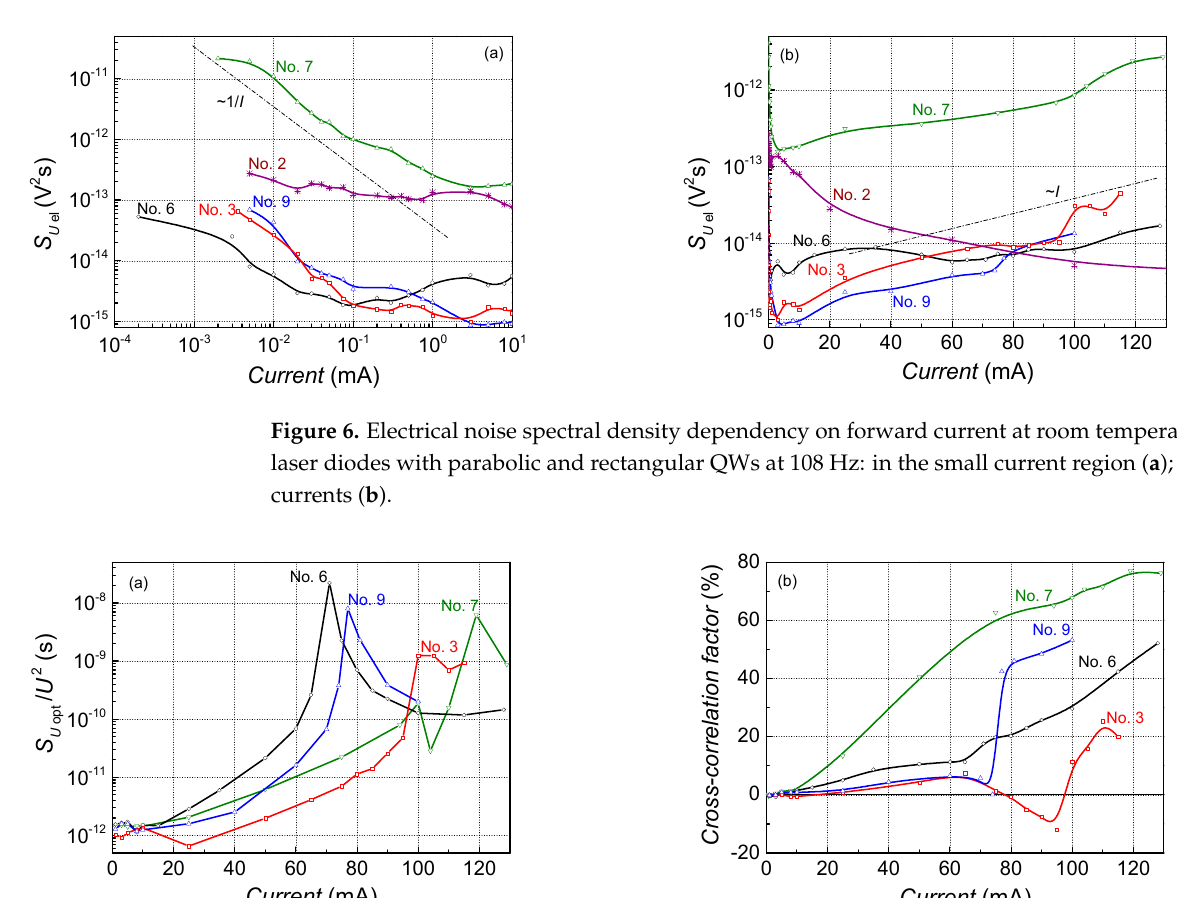
Figure 7. Normalized optical noise spectral density at 108 Hz ( a ) and cross-correlation between